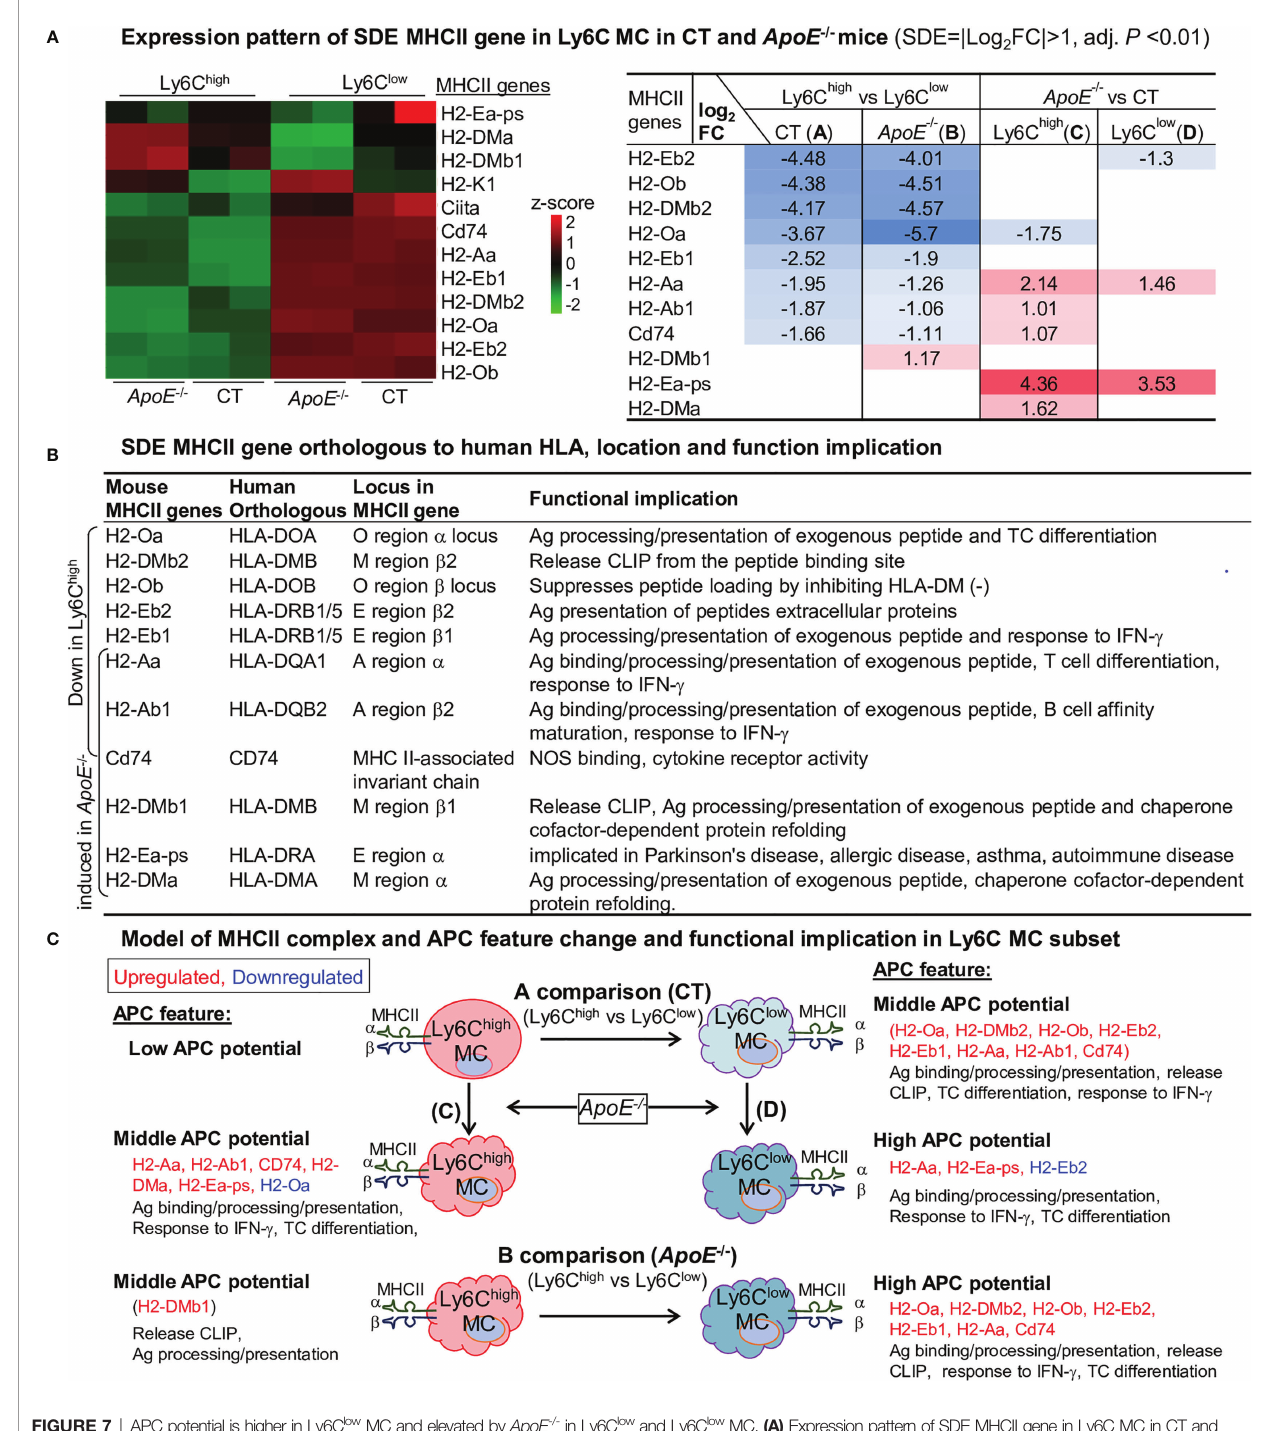
FIGURE 7 | APC potential is higher in Ly6C low MC and elevated by ApoE -/- in Ly6C low and Ly6C low MC. (A) Expression pattern of SDE MHCII gene in Ly6C MC in CT and ApoE -/- mice. Heatmap color density indicates the average expression level of a given gene normalized by z-score. Red/blue rainbow background in the table represents the gradient of increased/reduced fold change (log 2 FC>1, log 2 FC<-1). (B) SDE MHCII gene orthologous to human HLA, location and function implication. Identi fi ed mouse SDE MHCII gene orthologous to human corresponding HLA gene, gene locus and function implication were search from large database (https://www.alliancegenome.org). (C) Model of MHCII complex and APC feature and functional implication in Ly6C MC subset. Model outlines that eight SDE MHCII molecules were upregulated in Ly6C low MC in both mice and that ApoE -/- further induced MHCII gene expression. Cloud-like cell shape indicade APC potential. MHCII, major histocompatibility complex class II; Ag, antigen; IFN- g , Interferon gamma; CLIP, class II-associated invariant chain peptide; NOS, Nitrous Oxide